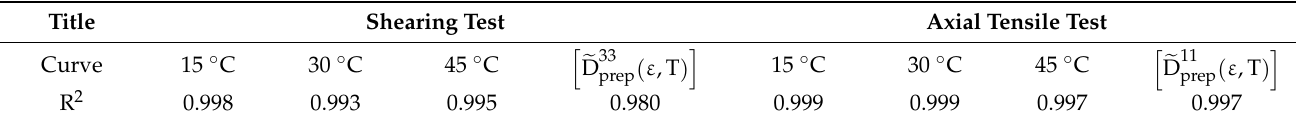
Table 4. The goodness of fit